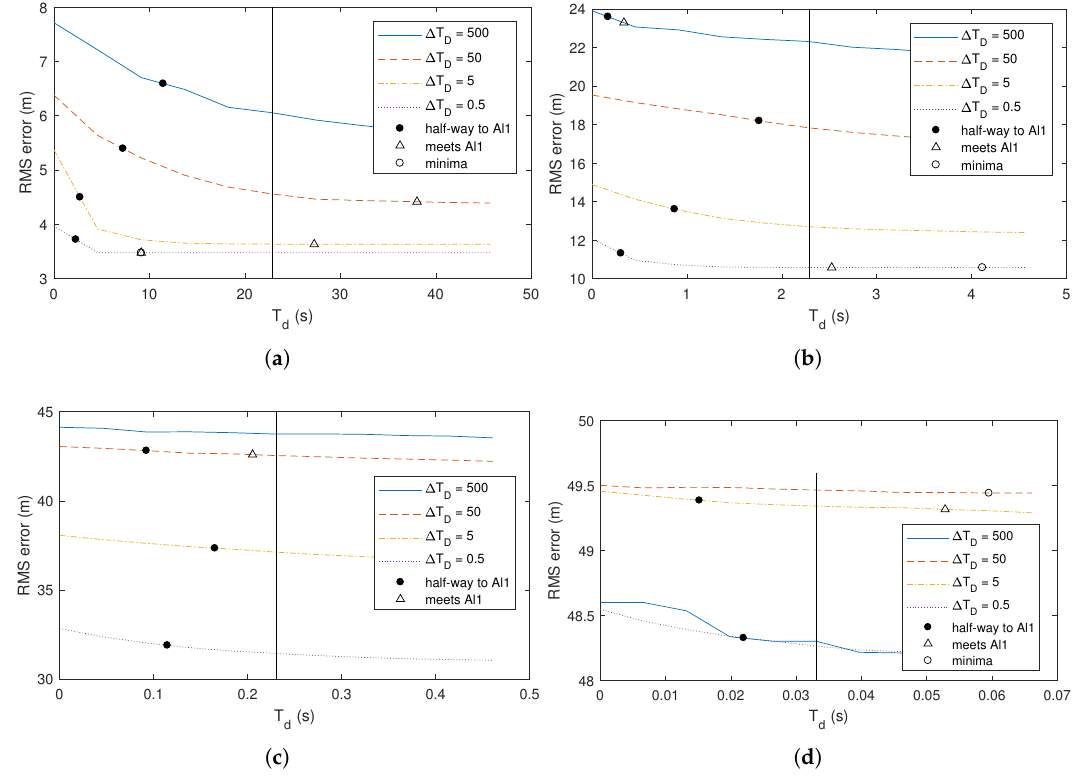
Figure 5. Performance of selective out-of-sequence filters as a function of the cut-off time T stale for a wide range of ∆ T D viewing a narrow time-scale. The vertical line represents the theoretical cut-off T d computed using (8) with a k min / k value of 0.6. ( a ) σ Q = 0.5, σ R = 50; ( b ) σ Q = 5, σ R =